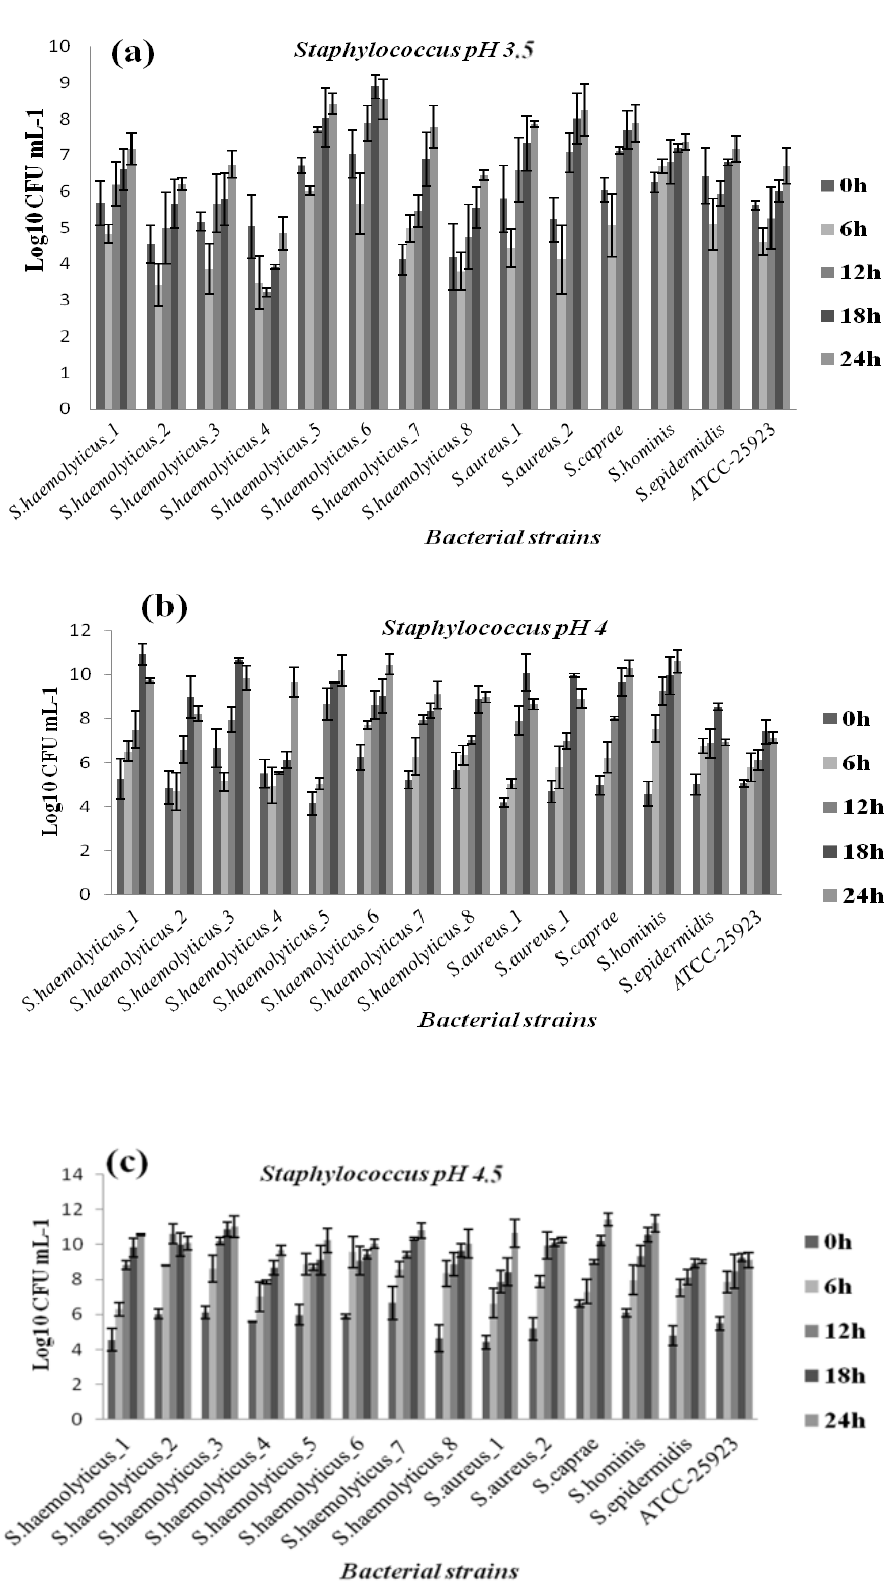
Figure 5. Growth of vaginal Enterococcus faecium strains at pH 3.5 ( a ); pH 4 ( b ); and pH 4.5 ( c ).